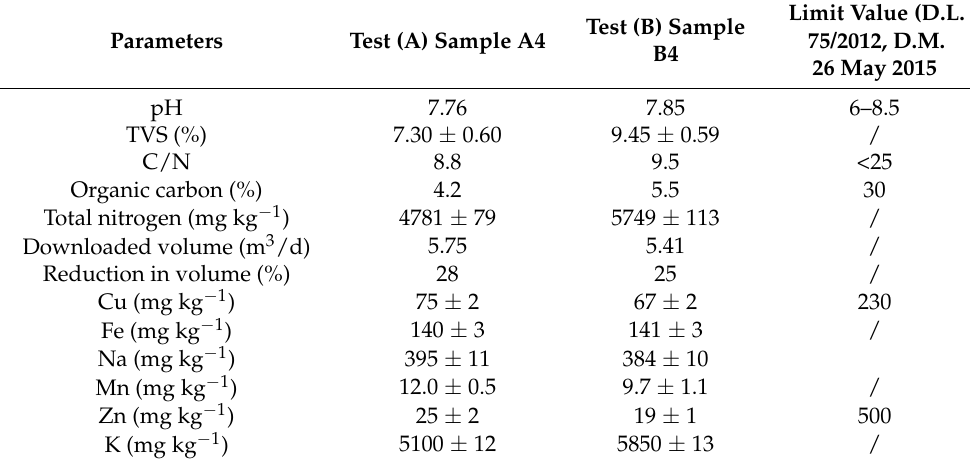
Table 5. Characteristics of